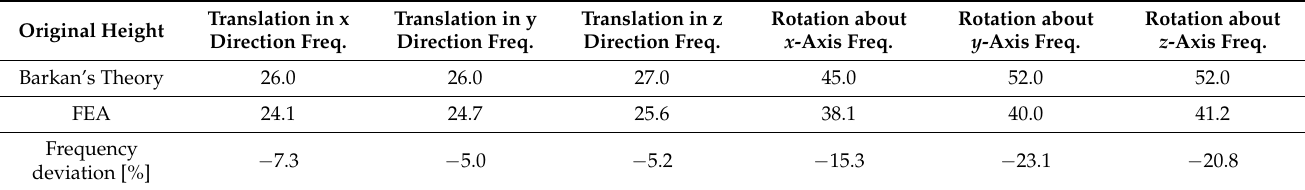
Original Height